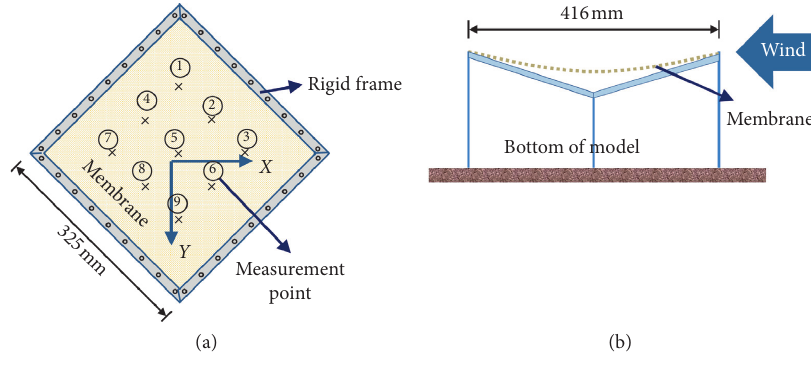
Figure 4: Experimental system. Table 1: Physical parameters of the experimental model.